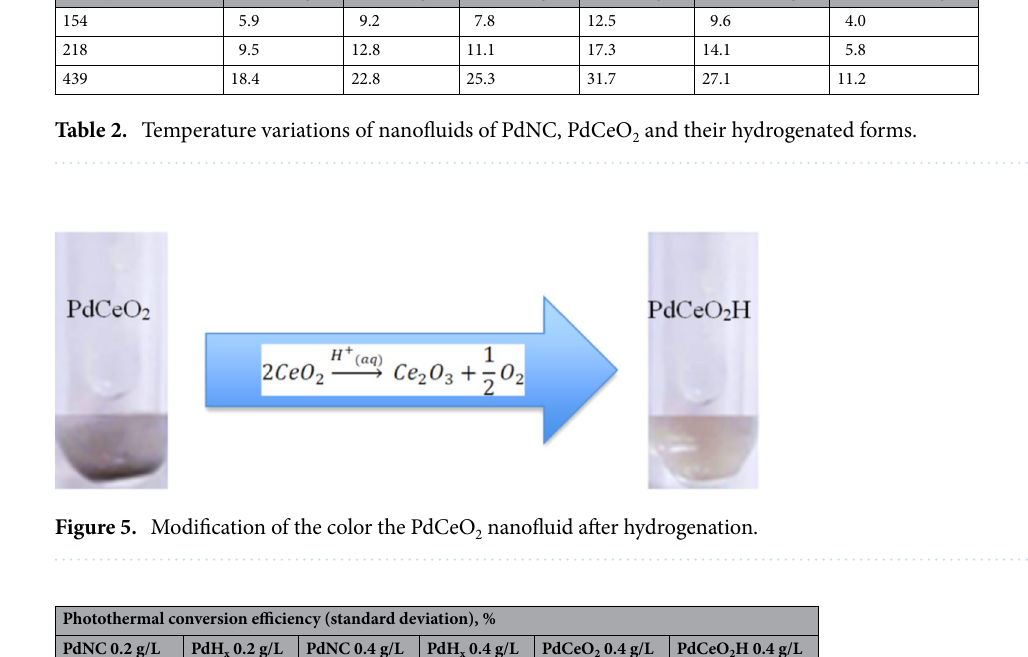
Photothermal conversion efficiency (standard deviation), % PdNC 0.2